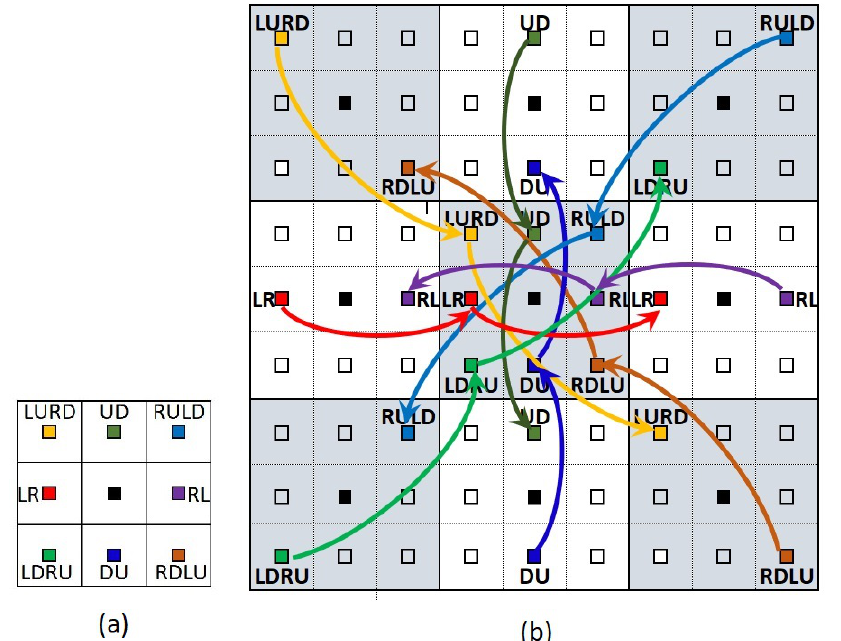
Figure 9. One cell with its centre marked with a black square is divided into eight nodes correspond- ing to its eight allowable moves is shown in subfigure ( a ). These eight nodes are shown in different colors surrounding the black center. Eight couples of input and output direct-move edges at each cell are shown for the central cell in a 3 × 3-cell example in subfigure ( b ). The color of each couple edge is the same with the color of its corresponding